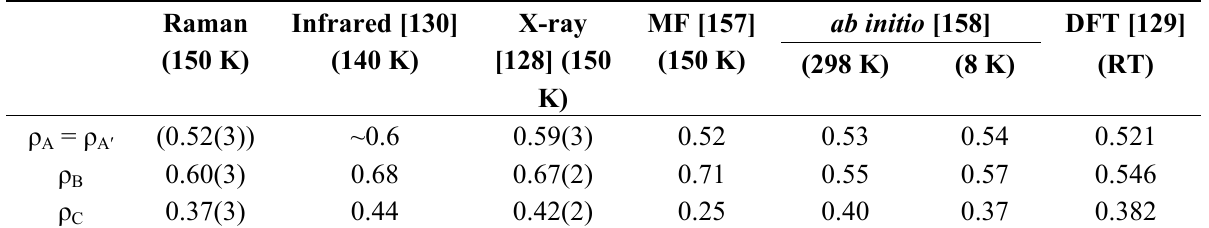
Table 3. Site hole numbers of metallic α -(BEDT-TTF) calculation, and DFT denotes density functional